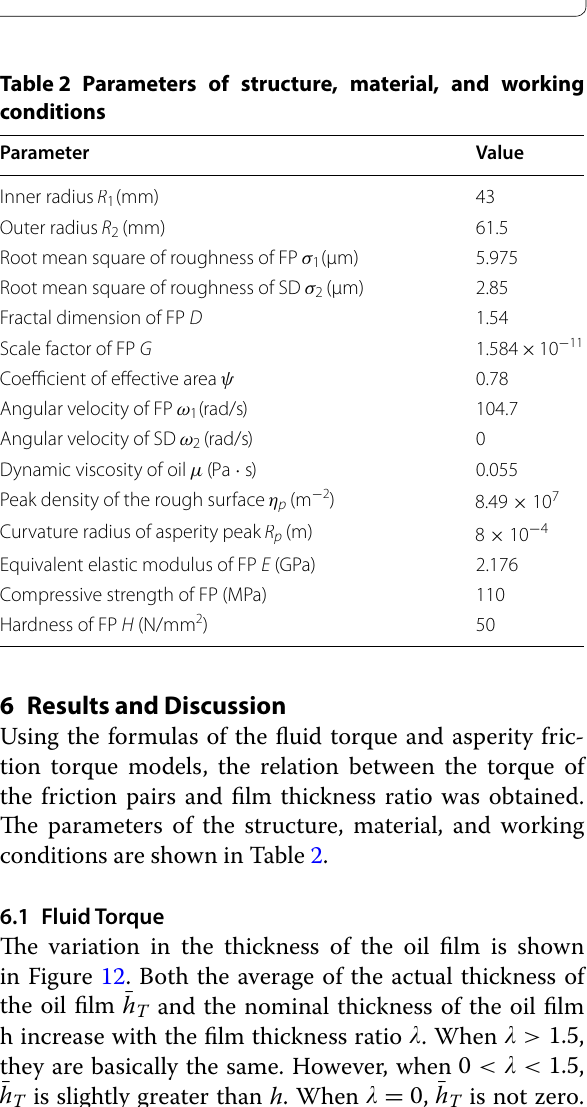
Figure 10 Components of the test rig